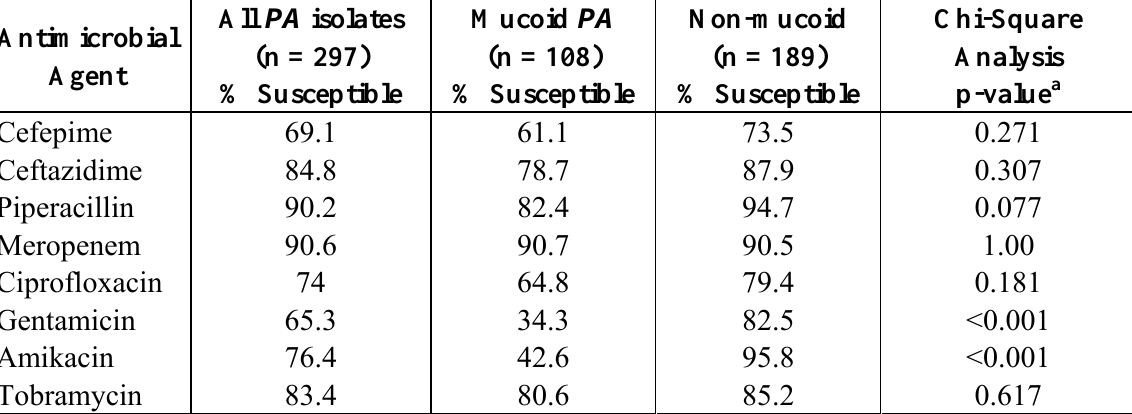
Table 1. Differences between non-mucoid and combined percent susceptible data.